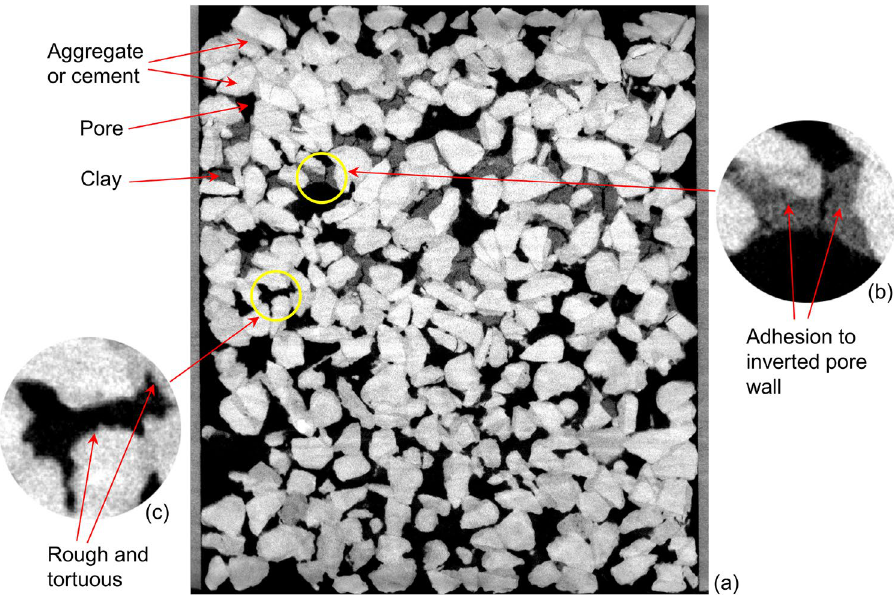
Figure 12. The CT image of the dried clay-clogged sample after all 30 washing cycles: ( a ) vertical image; ( b ) particles adhering to inverted pore wall; and ( c ) rough tortuous pore